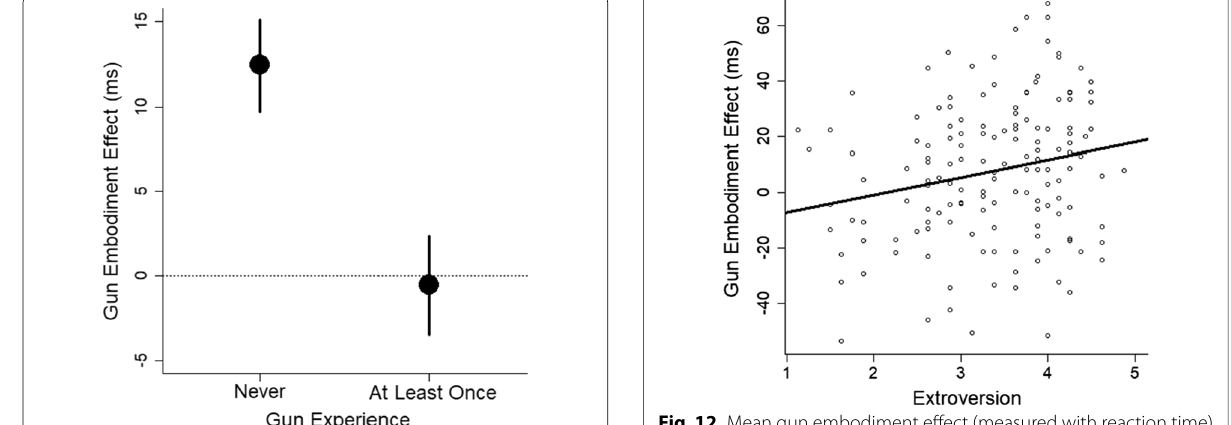
Fig. 12 Mean gun embodiment effect (measured with reaction time) is plotted as a function of extroversion. Each circle represents one participant. Line represents linear